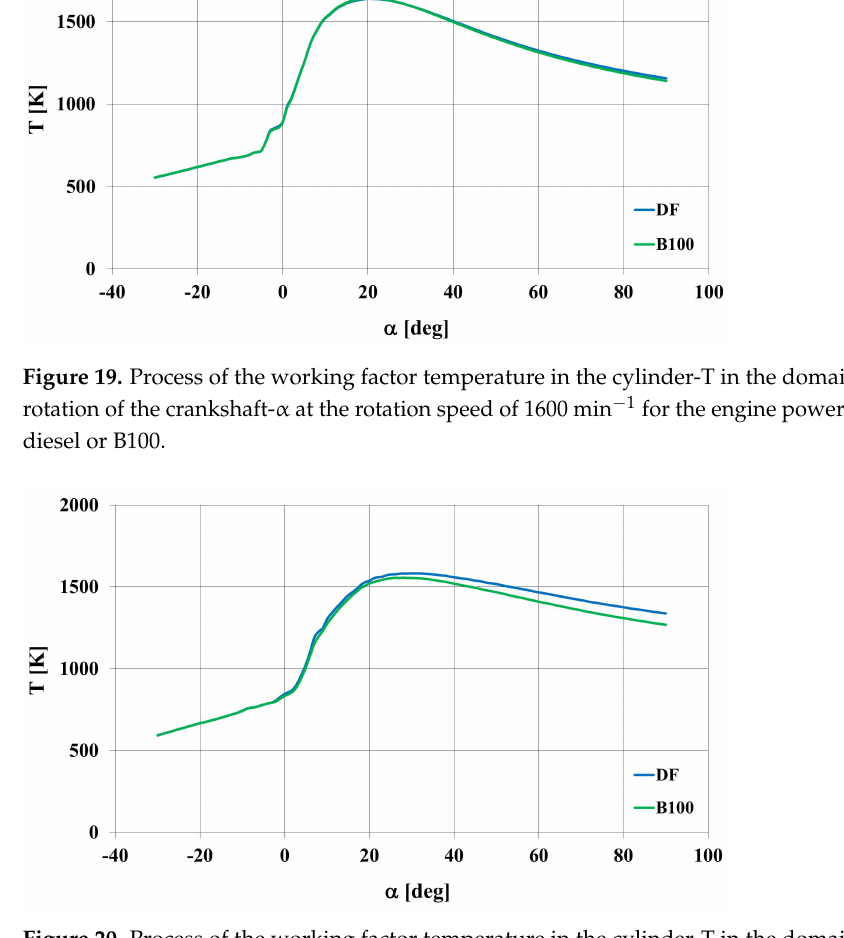
Figure 20. Process of the working factor temperature in the cylinder-T in the domain of the angle of rotation of the crankshaft- α at the rotation speed of 3600 min − 1 for the engine powered with fuels DF diesel or